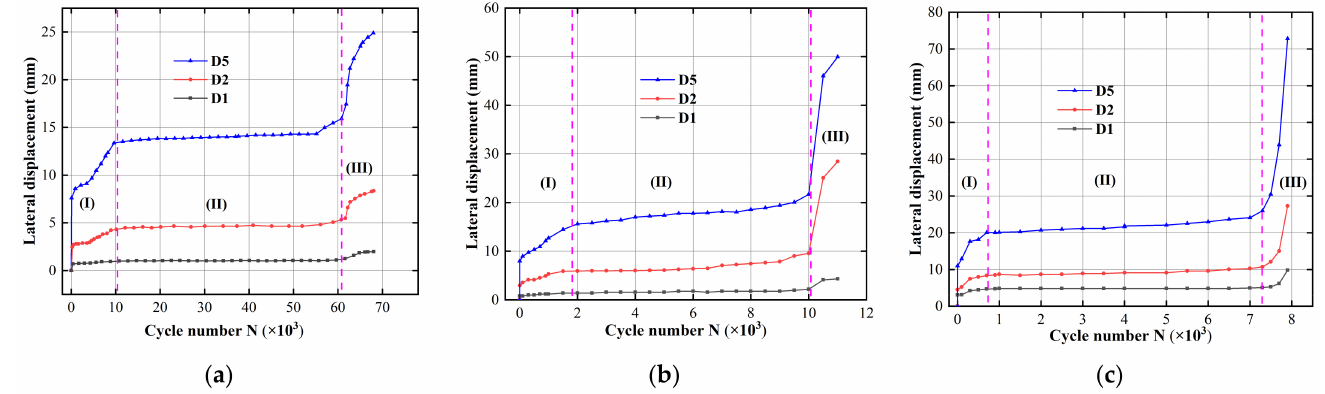
Figure 6. The curve of lateral displacement-cycle number: ( a ) SPA; ( b ) SPB; ( c )